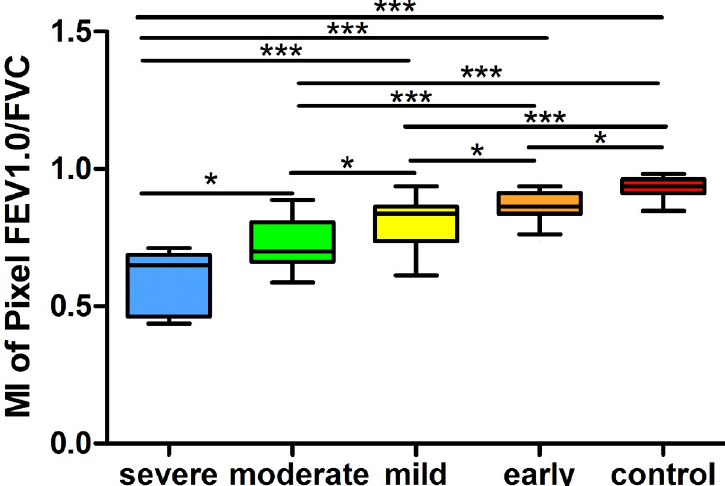
Fig 4. The MIs of pixel FEV1/FVC determined by EIT in the 5 groups. Boxes and whisker plots show the minimum, 25% percentile, median, 75% percentile, and maximum values. Significant differences among the groups are indicated by � p < 0.05, �� p < 0.01, and ��� p < 0.005. EIT, electrical impedance tomography; MI, the Mode index. FEV1, forced expiratory volume in 1 second; FVC, forced vital capacity.